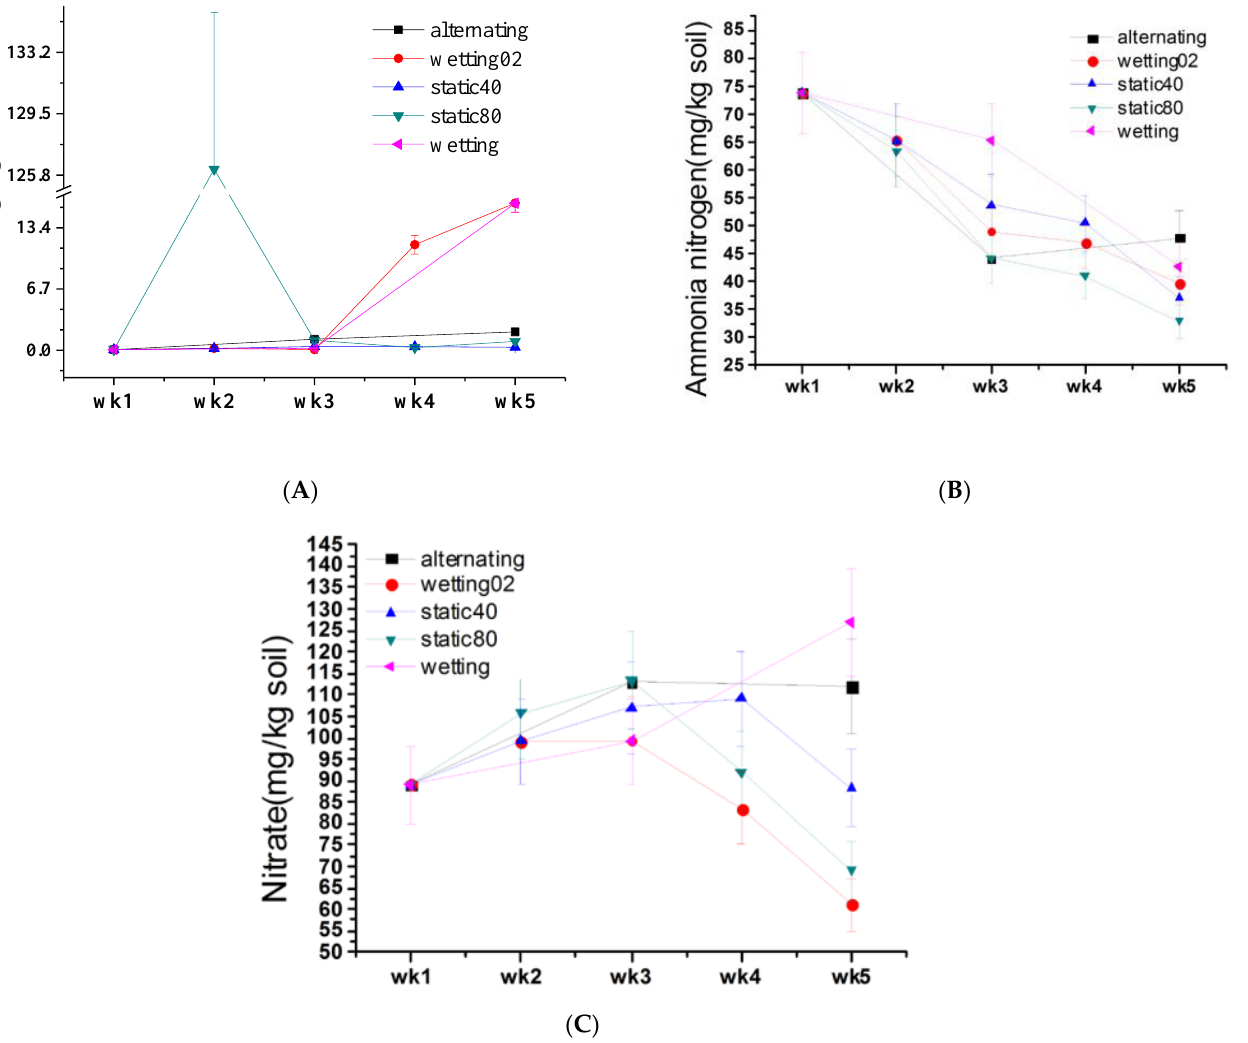
Figure 2. The temporal alterations of N 2 O emission ( A ), ammonium nitrogen ( B ) and nitrate ( C ) under four types of moisture regimes. Bars indicate ± 1SD; the statistical significance is detailed in the main body of the text and Table S2. Alternating: a20 (sampling at the end of the first week) → a80 (sampling at the end of the third week) → a40 (sampling at the end of the fifth week); wetting: a20 → w40 (sampling at the end of the third week) → w80 (sampling at the end of the fifth week); wetting02: a20 → w2_40 (sampling at the end of the second week) → w2_60 (sampling at the end of the third week) → w2_80 (sampling at the end of the fourth week) → w2_100 (sampling at the end of the fifth week); static(constant)40: a20 → s40 (sampling at the end of each week); static(constant)80: a20 → s80 (sampling at the end of each week).